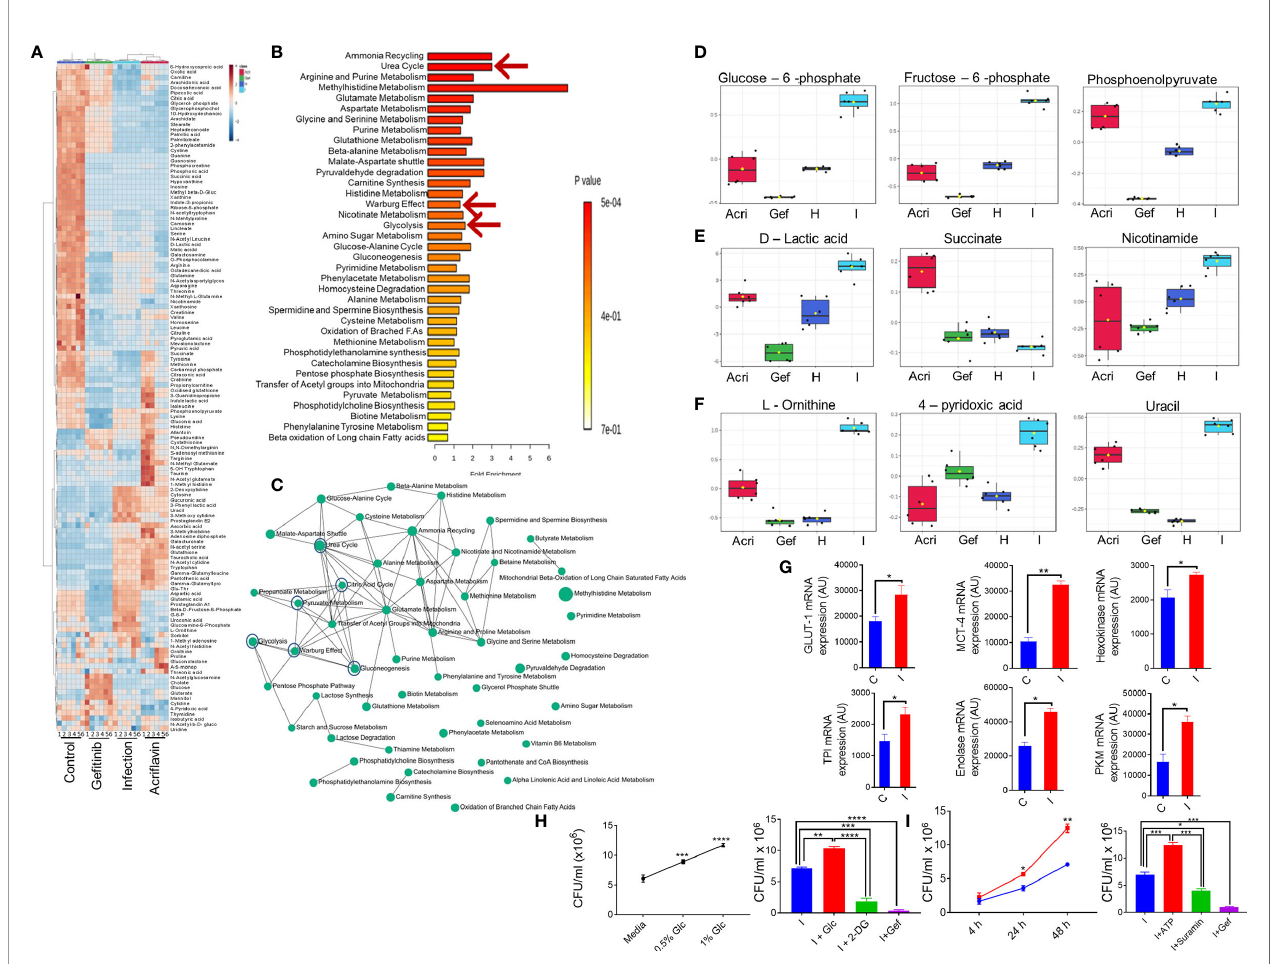
FIGURE 5 | Blocking EGFR signaling reprograms metabolomic changes in S. Typhimurium infection. Serum obtained from S. Typhimurium infected FVB mice receiving Ge fi tinib or Acri fl avin treatment was used for metabolomics pro fi ling using healthy serum control. (A) Heat map indicating changes in the metabolites for different groups (n=6 mice per group). (B, C) Pathway enrichment and pathway network. (D-F) shows the distribution of important metabolites for glycolysis, Warburg effect and urea cycle across different groups. (G) mRNA expression of genes involved in glucose transport and glycolysis in the presence or absence of S. Typhimurium infection in BMDM cells, bars show duplicate values for each gene. (H, I) dose kinetics for glucose and ATP response against intracellular replication of S. Typhimurium inside BMDM cells, Data are representative of mean ± SEM from one individual experiments *P < 0.05, **P < 0.01, ***P < 0.001, ****P < 0.0001 (Student ’ s